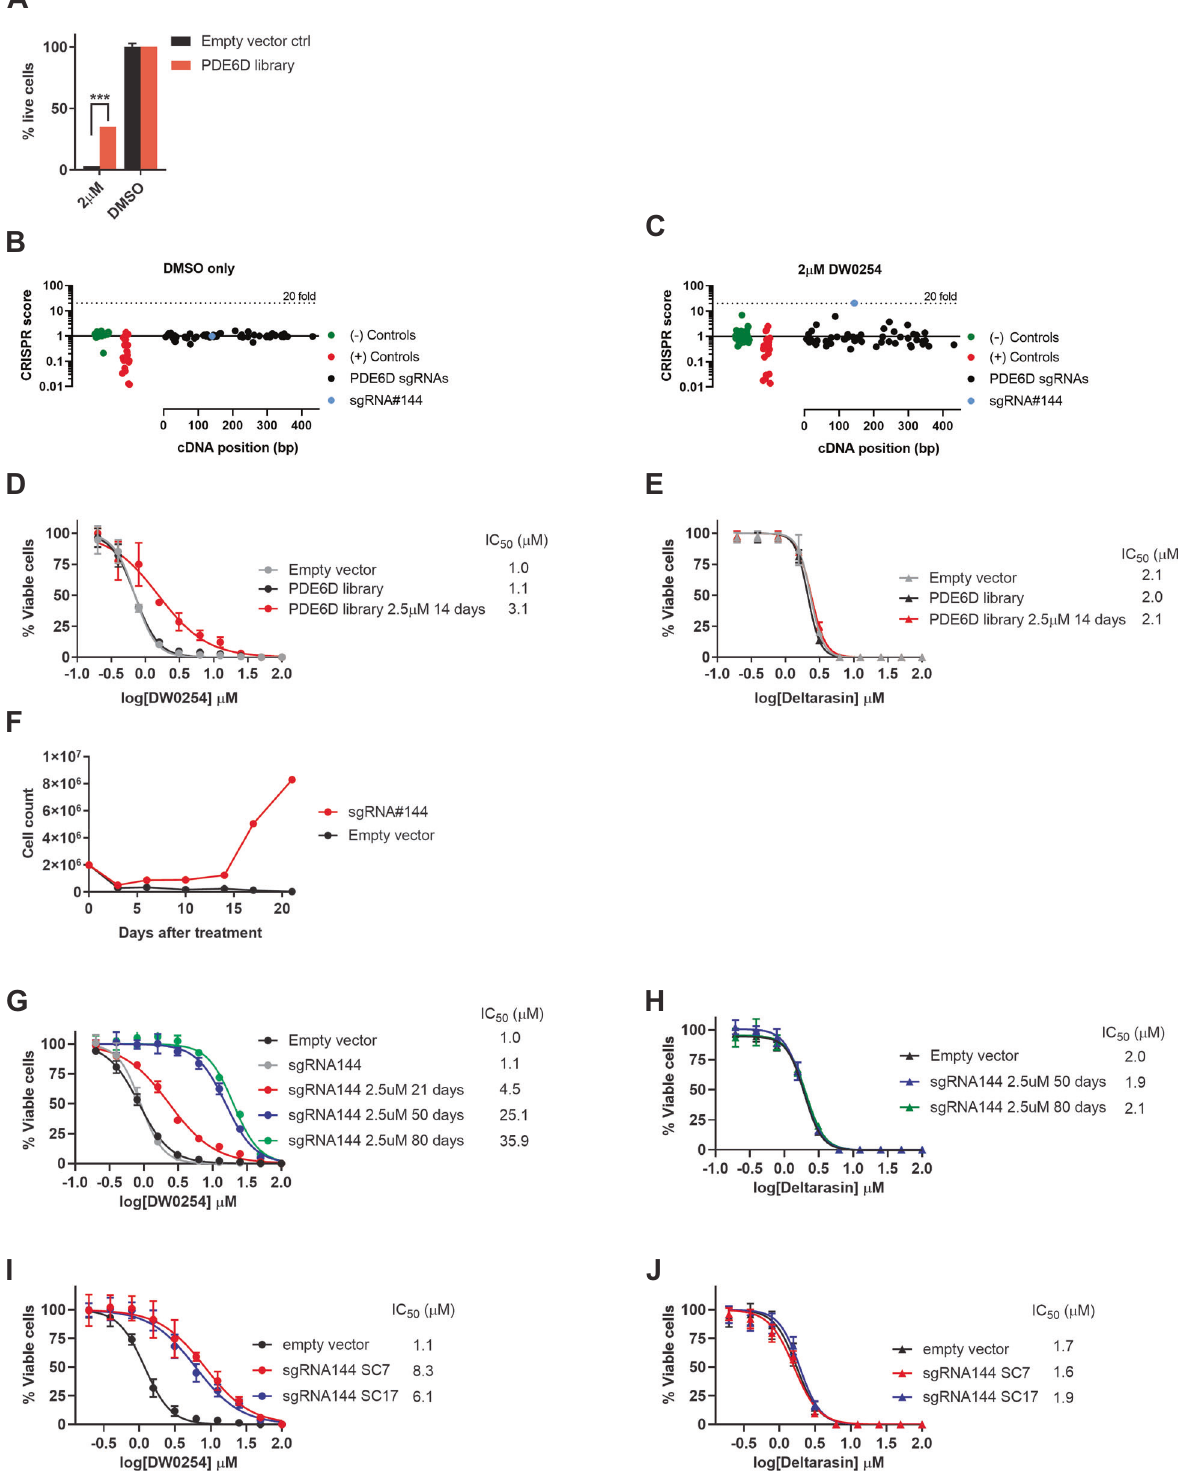
KRAS4B in RS4;11 and CCRF-CEM (Fig. 6B, C). To further test whether the DW0254-dependent disruption of the interaction between PDE6D and RAS is associated with altered subcellular localization of RAS, we used fl uorescently tagged mutant RAS proteins to analyze RAS localization before and after treatment with DW0254. Transfection of RAS proteins into